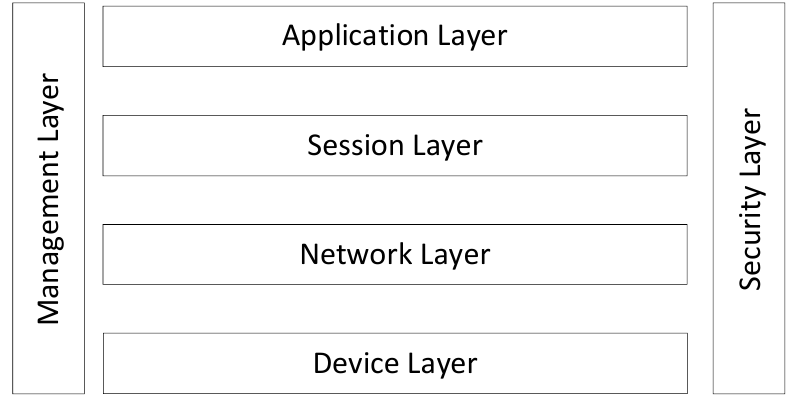
Figure 1. IoT Reference Architecture